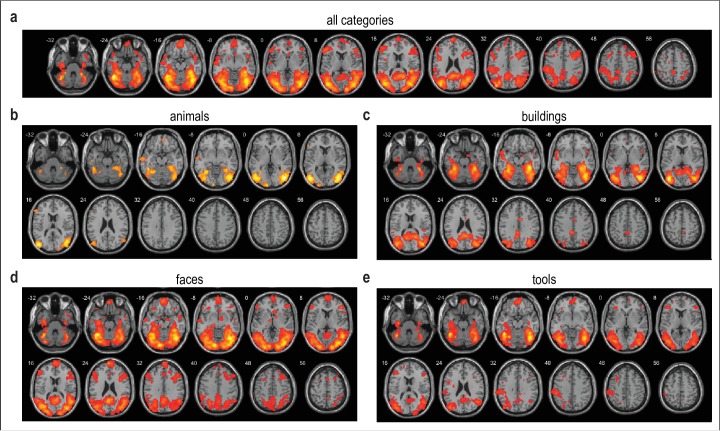
Brain regions demonstrating category selectivity during initial learning.(a–e) Multivoxel pattern analysis of initial learning data reveals widespread category specificity across the four object categories, and for each of the four object categories individually. fMRI activity is shown at p < 0.001 uncorrected, and images are overlaid on a canonical single-subject T1-weighted MRI scan. This result was visualized using the xjView toolbox (http://www.alivelearn.net/xjview).